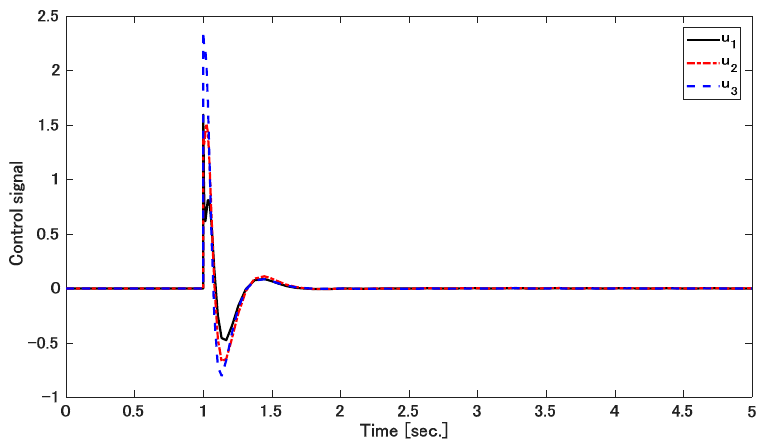
Figure 6. Control signal of three-area power system.